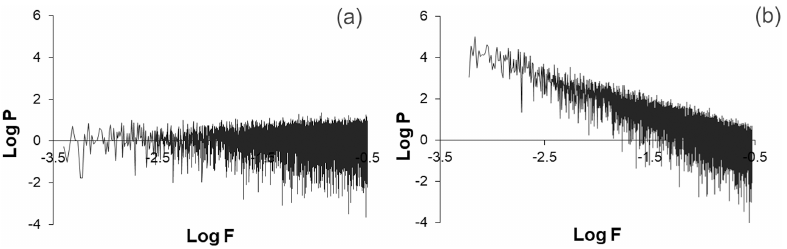
Figure 2. Typical plot of the power spectrum of simulated data sets with different spectral regressions, (a) β = 0 . 001 and (b) β = 1 . 655.